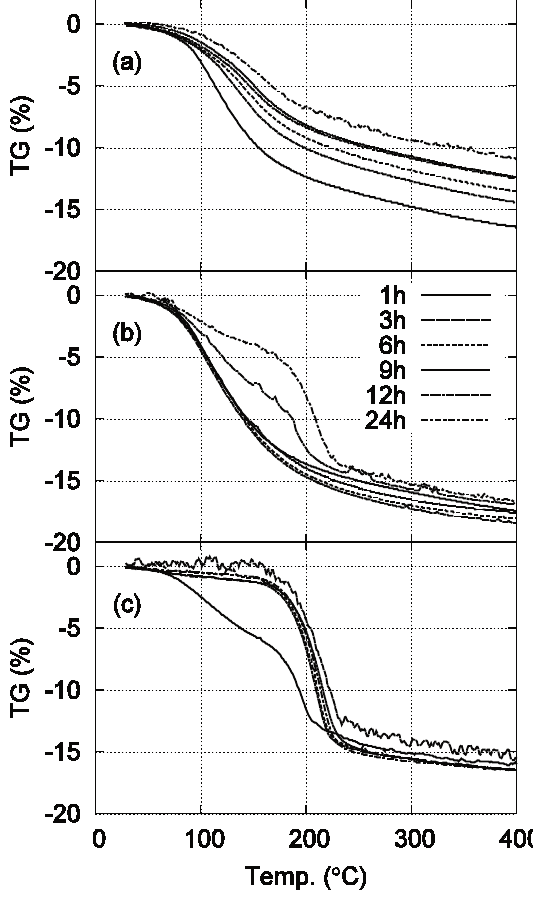
Figure 6. The results of thermo-gravimetry analysis for the samples after the experiments. (a) Experiment I (Dry, 95°C, A), (b) Experiment II (Humid, 95°C, A), (c) Experi- ment IV (Humid, 160°C,